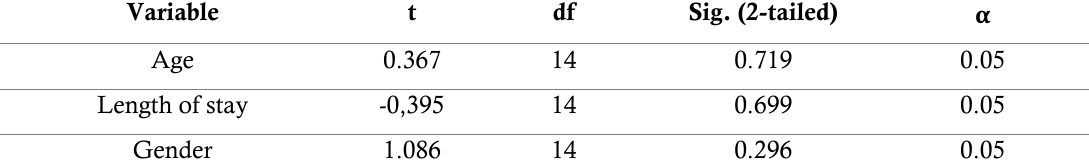
Table 4 Results of Paired Sample t-test of Household Effluent Management Behavior